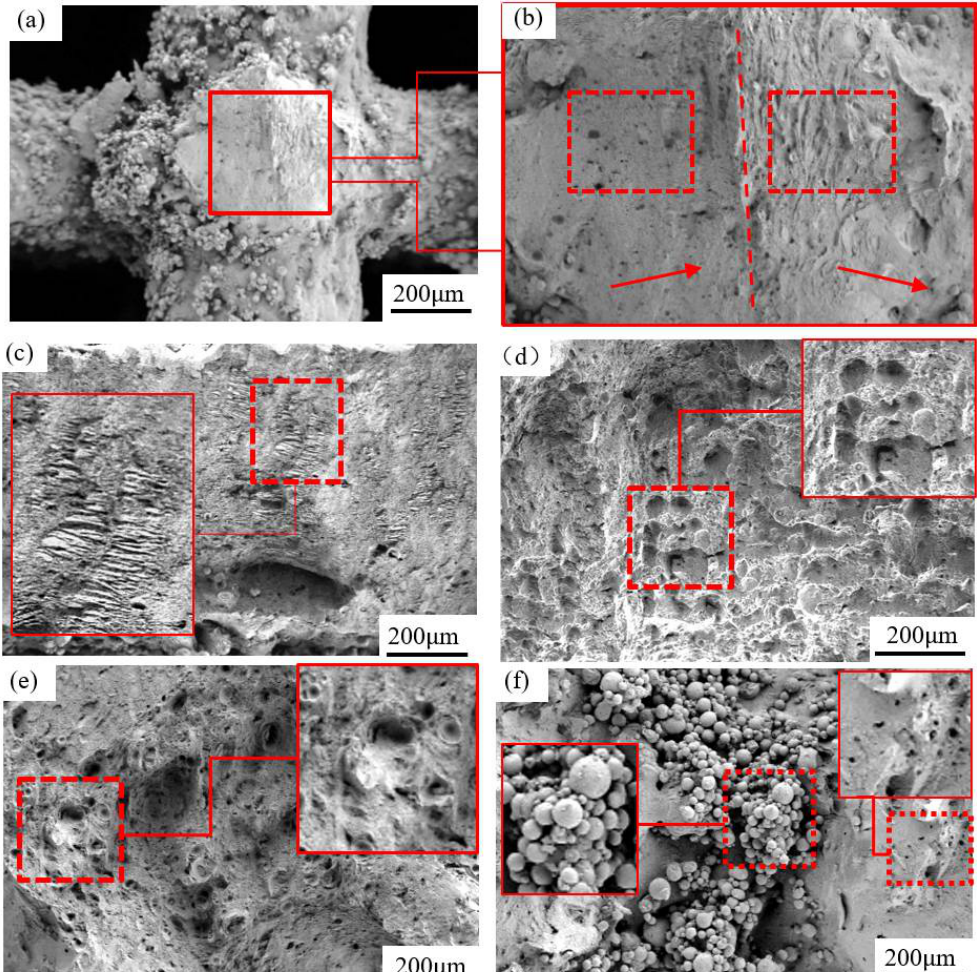
Figure 6. Fracture morphology of SLM specimen. ( a ) strut; ( b ) enlarged view of strut; ( c ) tensile band; ( d ) pores in sample with lower comatibility; ( e ) pores in sample with higher comatibility; ( f ) unmelted powder.